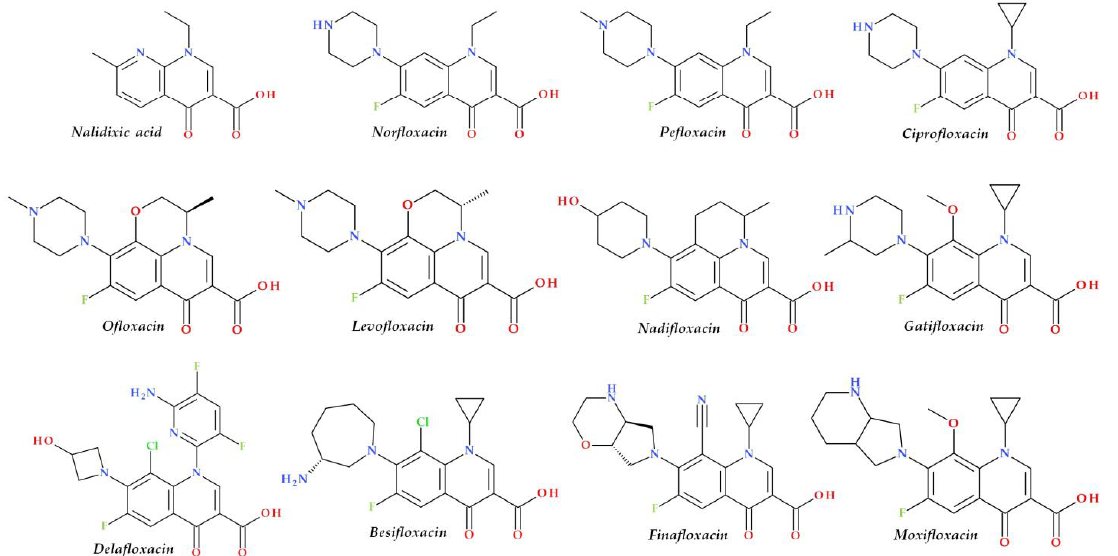
Figure 2. Chemical structures of FQs used in therapy and approved by the EMA and FDA (EMA — European Medicine Agency, FDA — Food and Drug Administration, FQs — fluoroquinolones). The N1 position is involved in pharmacokinetic properties and overall potency. Sub- stitution with a cyclopropyl moiety increased the activity against Gram-negative bacteria